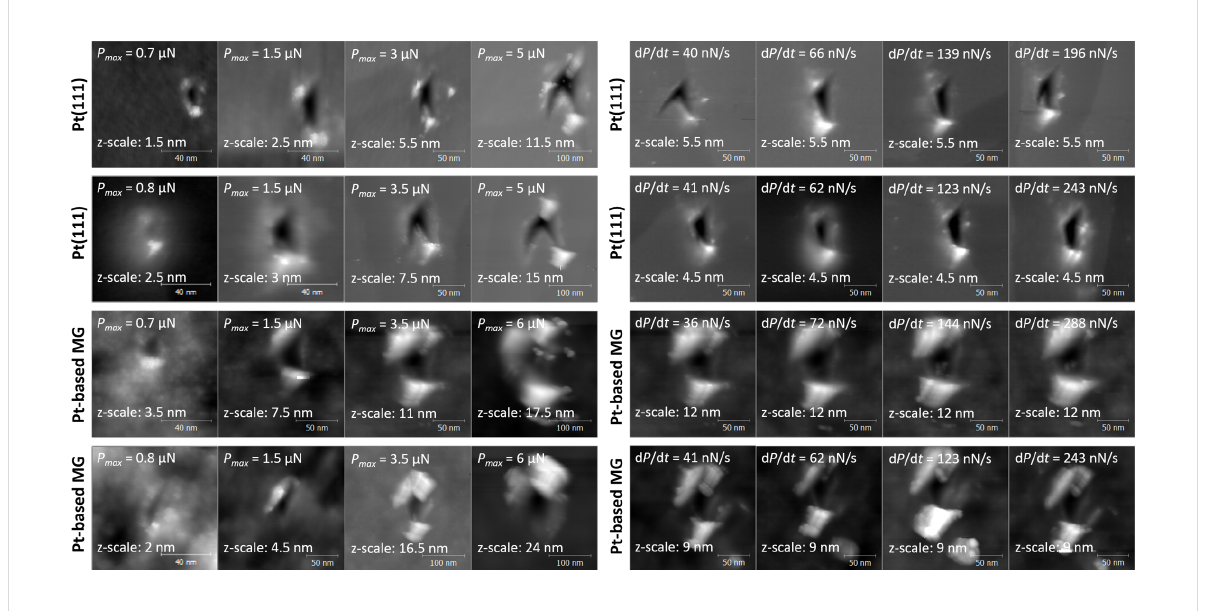
Figure 4: nc-AFM images of indented surfaces as a function of (left) the maximal loads P max and of (right) the loading rate d P /d t on Pt(111) and Pt 57.5 Cu 14.7 Ni 5.3 P 22.5 metallic glass; all AFM indentation measurements were performed with the same diamond-coated AFM tip that was analyzed in Figure